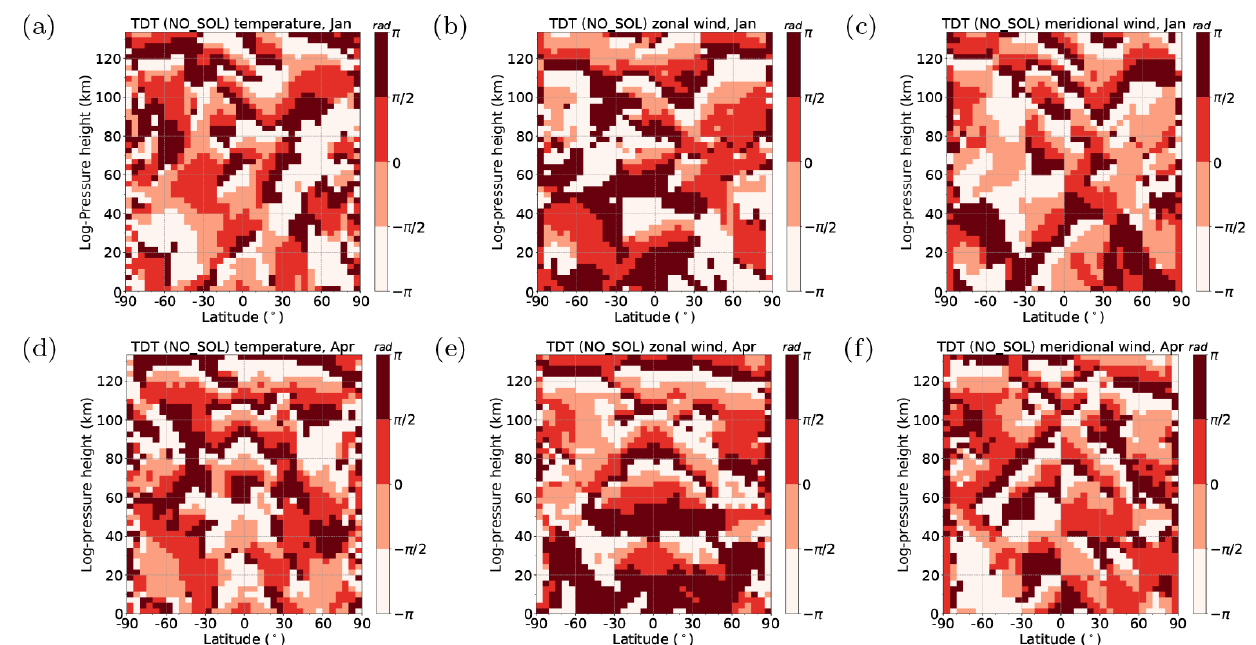
Figure 9. Zonal mean TDT phases (NO_SOL). (a, d) Temperature, (b, e) zonal wind, (c, f) meridional wind. (a–c) Solstice (January) conditions. (d–f) Equinox (April)